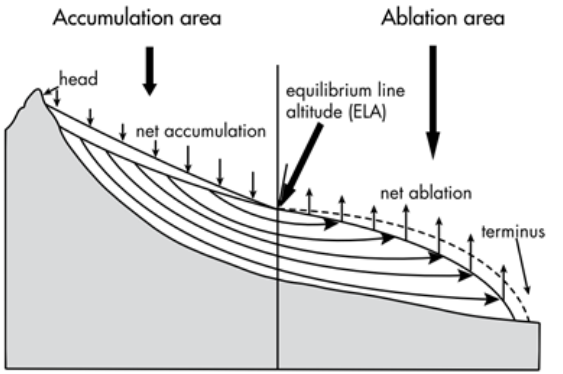
Figure 2. Division of accumulation area and ablation area of glacier. Figure cited from